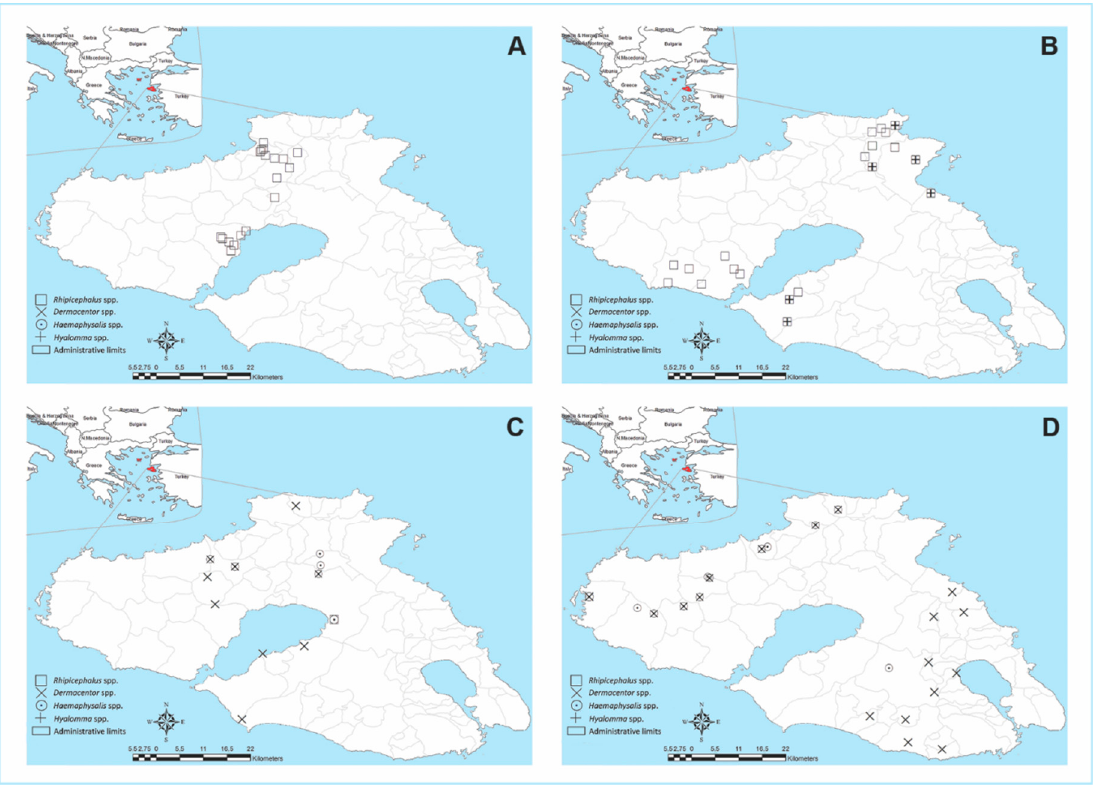
Figure 2. Tick genera found based on the month (( A ) = May, ( B ) = June, ( C ) = September, ( D ) = October) of sampling and farm location.